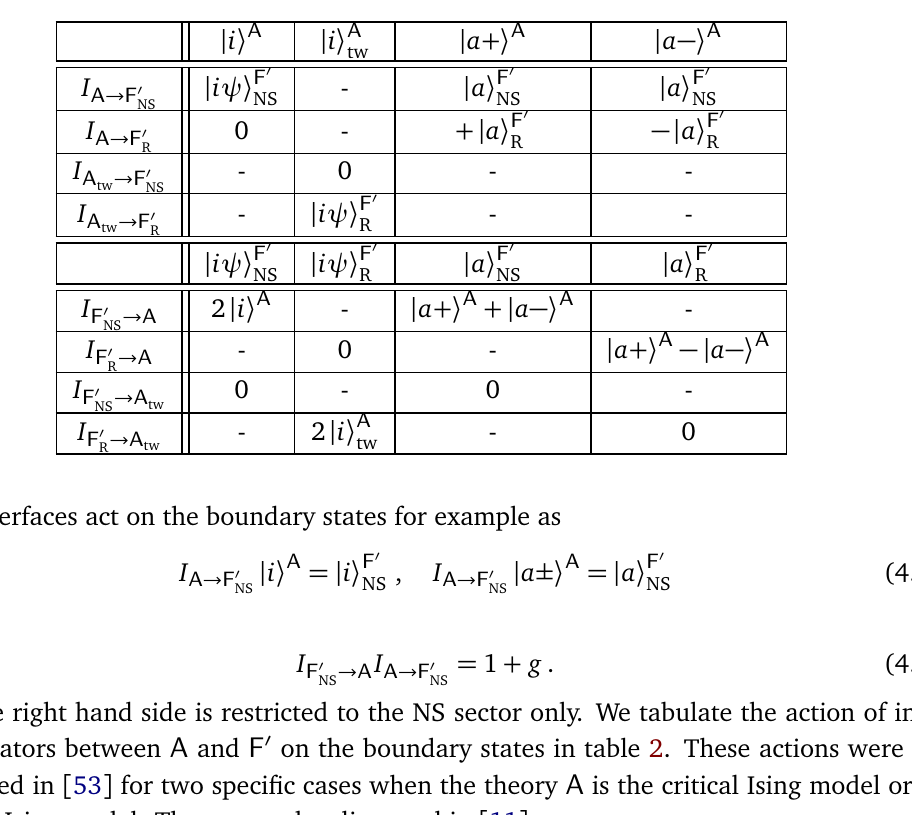
Table 2: Action of interface operators (between theories A and F (cid:48) ) on the boundary